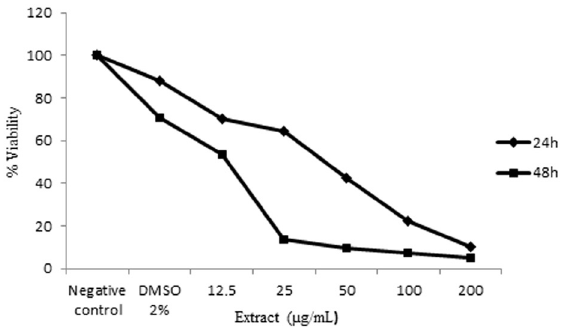
Figure 1 - Effect of H. courbaril extract on B16F10- Nex2 melanoma cell line using Trypan blue viability assay for 24 and 48 h exposure periods. The values represent the means ±